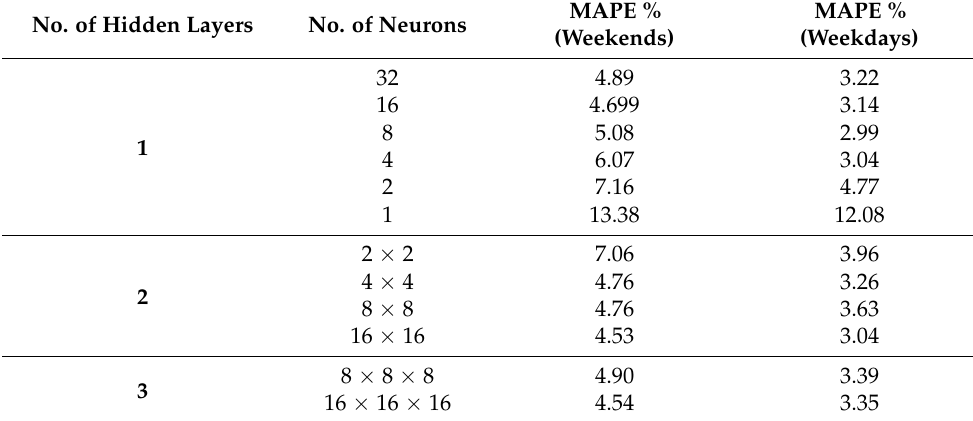
Table 4. Selection of the hidden